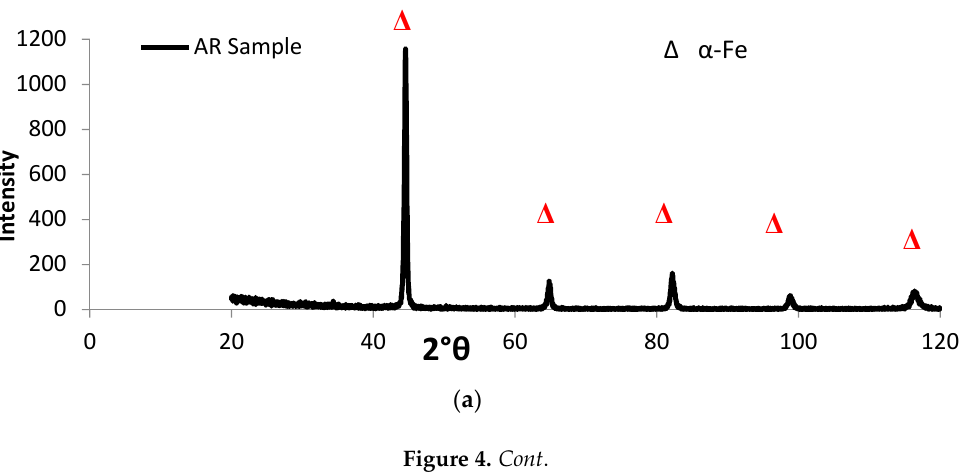
Figure 3. Optical image of microstructure (magnification 200×) of conventionally hardened AISI 416 stainless steel.